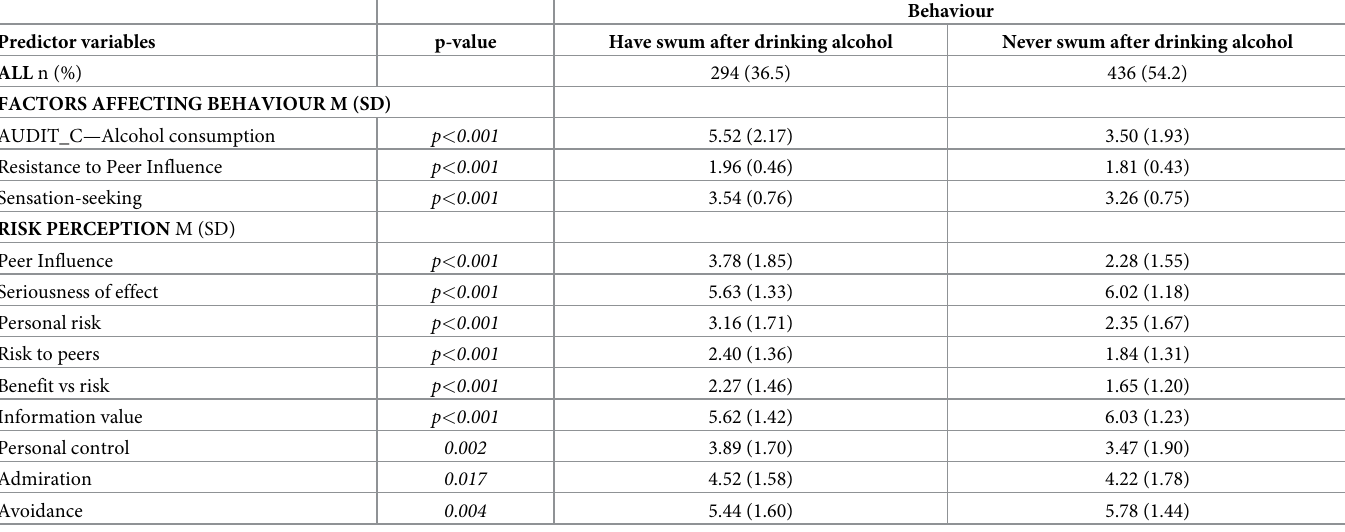
Table 2. Bivariate analyses of behaviour and factors affecting behaviour (AUDIT-C- alcohol consumption, resistance to peer influence, sensation-seeking and risk perception).